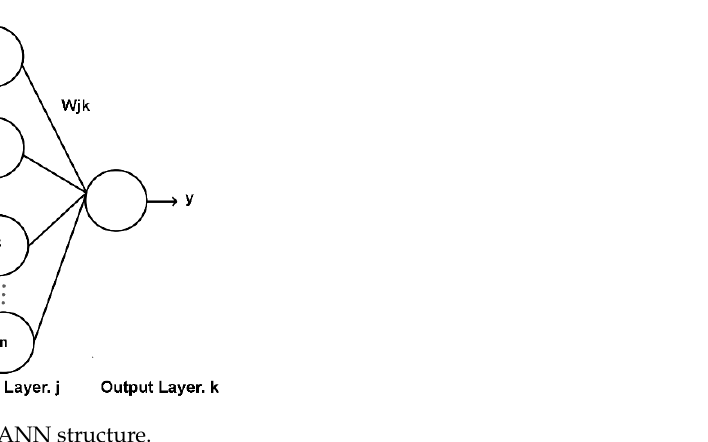
Figure 3. Three ‐ layer ANN structure. Figure 3. Three-layer ANN